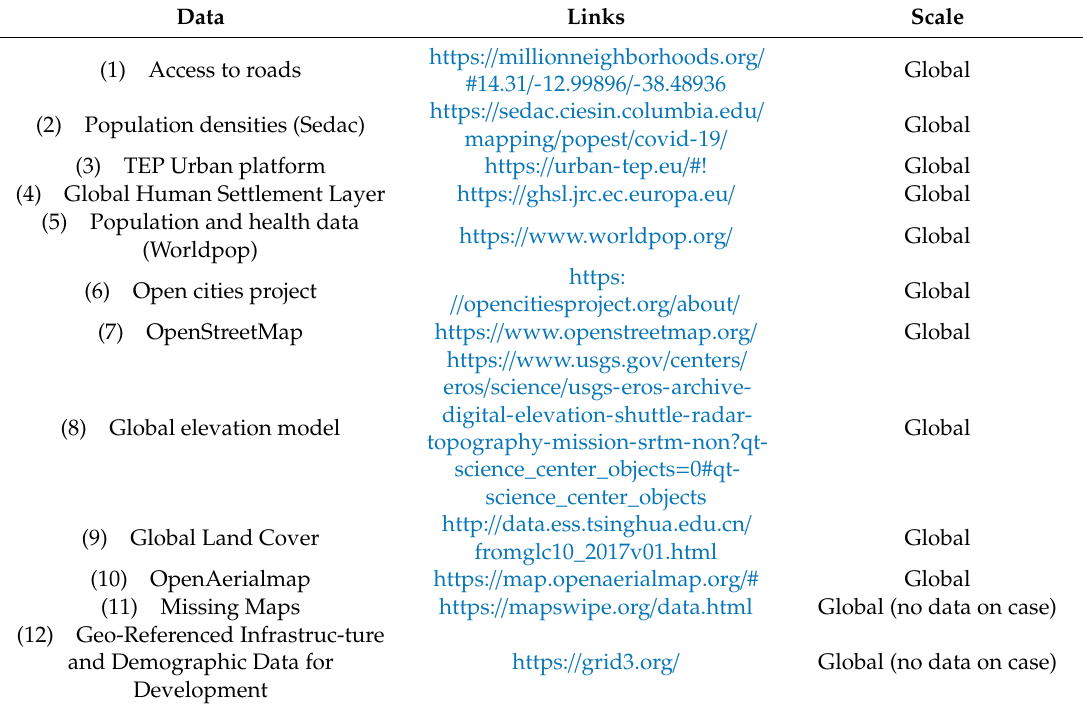
Table 2. Relevant global data and local repositories relevant to provide base data for COVID-19 responses for the example of Salvador, Brazil (for non-EO